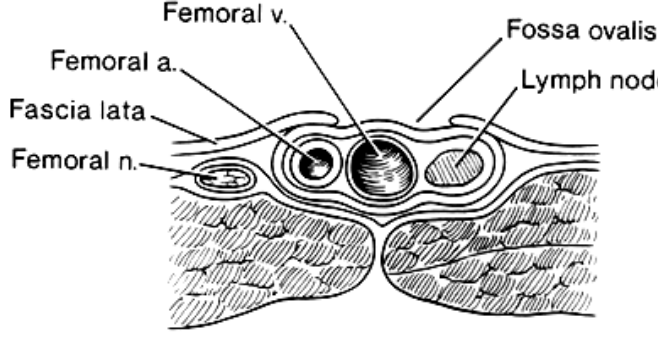
FIGURE 6. Anatomy of the femoral